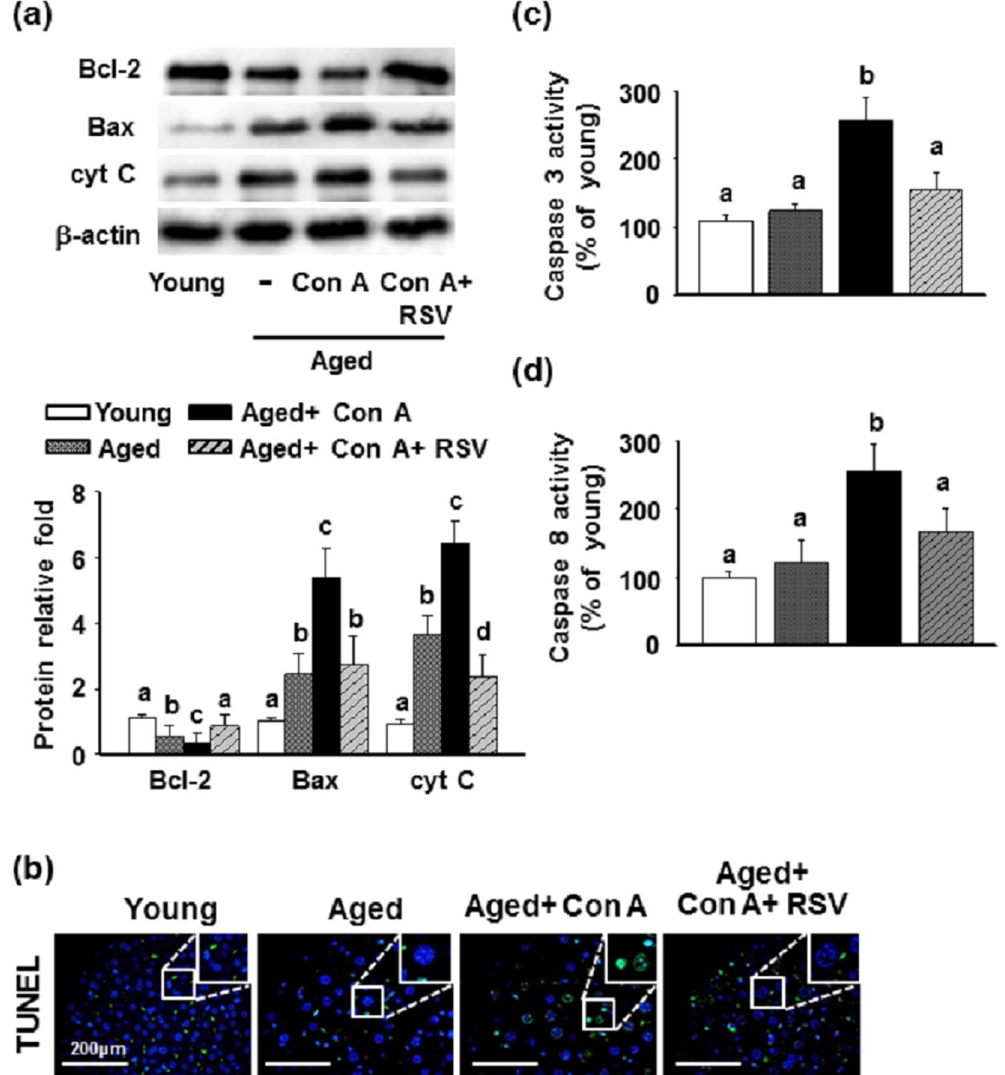
Figure 5. Effects of resveratrol on apoptotic cell death in the livers of aged mice treated with Con A. ( a ) Protein lysates were analyzed using Western blotting with the antibodies against Bcl-2, Bax and cytochrome C (cyt C). Data are means ± SEMs from three independent measurements. ( b ) TUNEL staining with FITC fluorescein label. DAPI is the nuclear stain. The images are shown at 200 × magnification, with the upper right grid at 400 × enlargement for selected squares. The length of scale bar was indicated as 200 μ m. ( c and d ) The hepatic activity of caspase 3 and caspase 8 (n = 7 in each group). Different letters denote statistically significant differences (p < 0.05) between